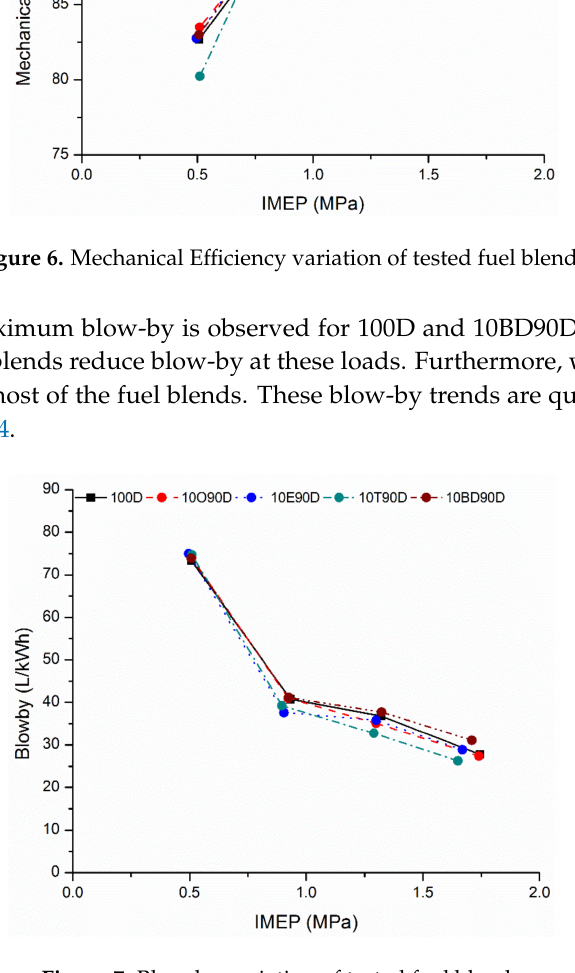
Figure 7. Blow-by variation of tested fuel